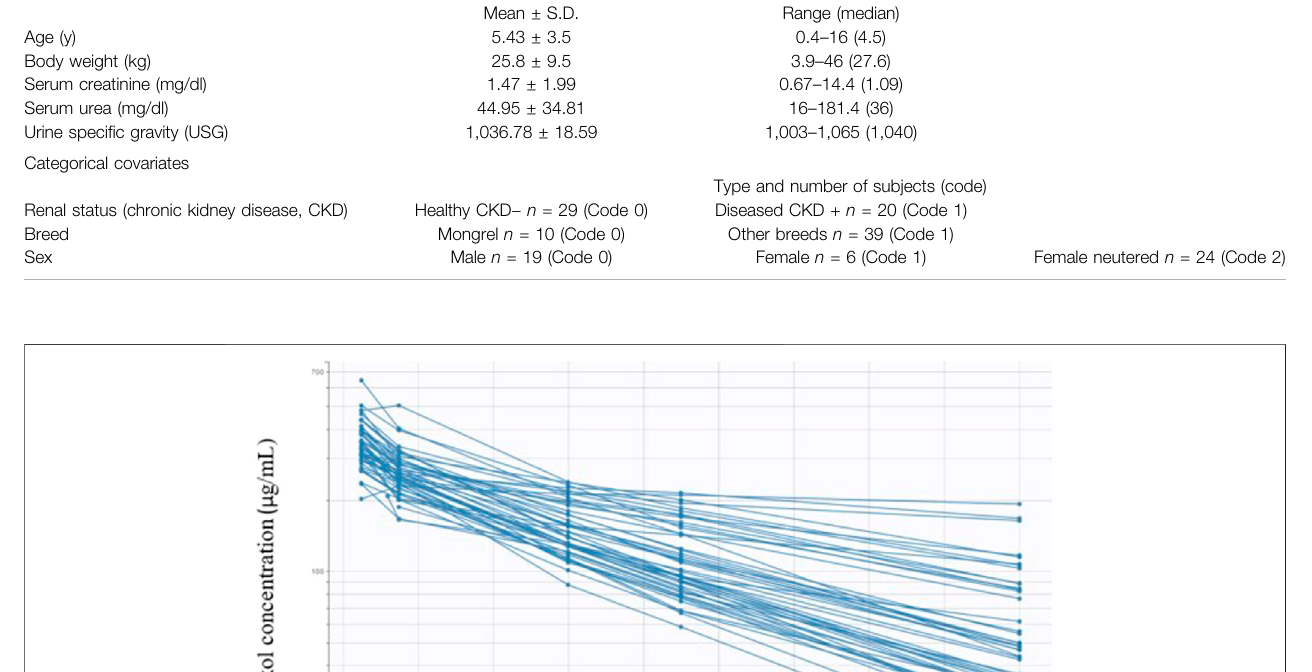
TABLE 1 | Animal characteristics, covariates, and coding used in Pop PK analysis. Continuous covariates